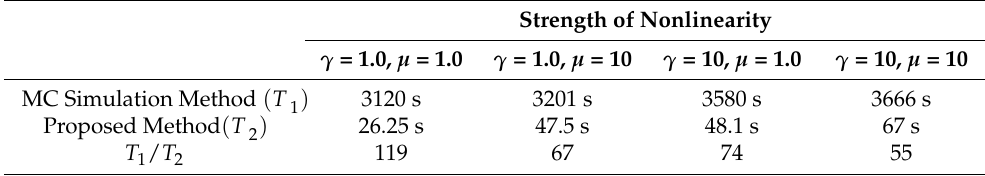
Table 3. Comparison of the required time by the MC simulation method and the proposed method. Strength of